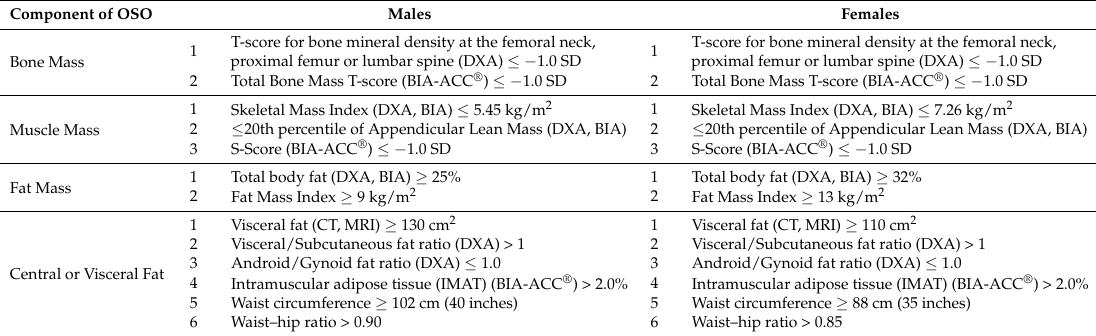
Table 1. The revised physical diagnostic criteria for osteosarcopenic obesity in males and females. Component of OSO Males Females 1 T-score for bone mineral density at the femoral neck, proximal femur or lumbar spine (DXA) ≤ − 1.0 Bone Mass